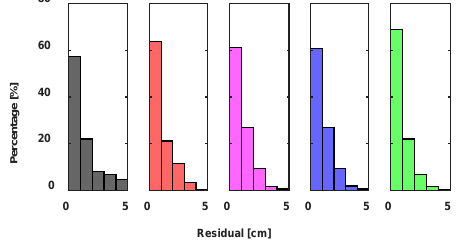
Figure 5. Histograms of the points’ residuals of all resulting point clouds for Diemen2 dataset and for all methods, LiDAR-